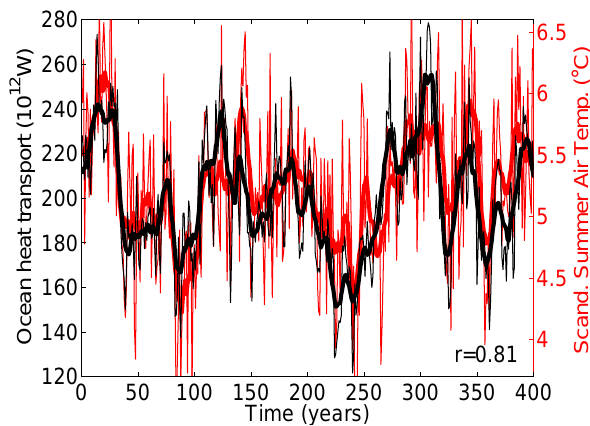
Fig. 5. Time series of ocean heat transport into the Nordic Seas (black) and Scandinavian summer surface air temperature (red, see red box in Fig. 4), both filtered with a 11 years running average. Thin lines show unfiltered time series. Curves correlate with r=0.81 and ocean heat transport leads by one year.